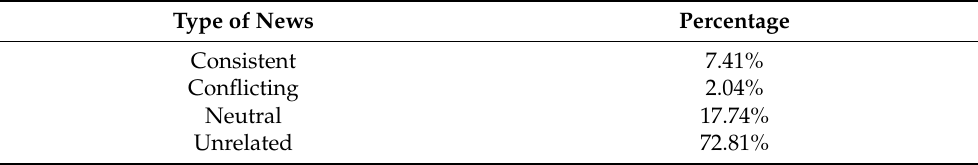
Table 3. Distribution of data